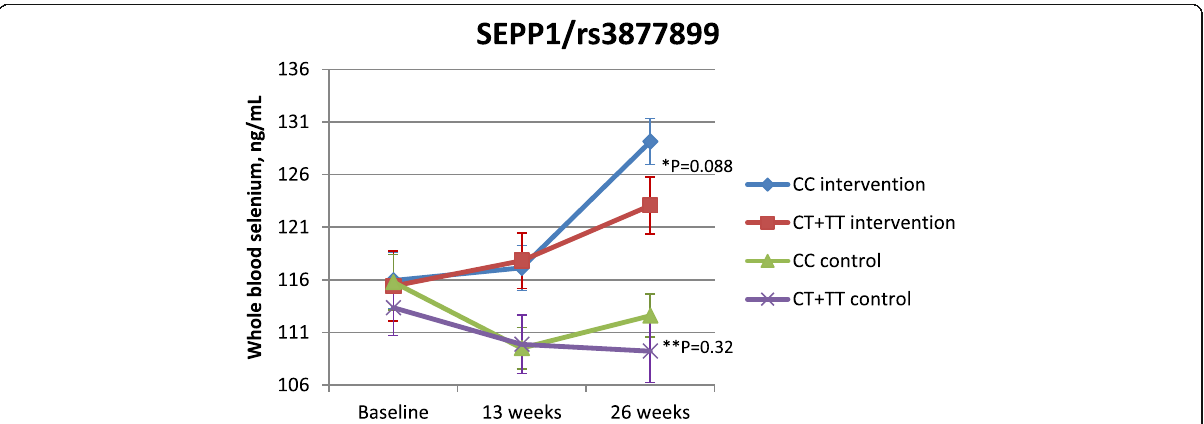
Fig. 1 Association between mean concentrations of whole blood selenium and the SELENOP /rs3877899 polymorphism. Mean concentrations of whole blood selenium ± SD for the intervention and control group estimated by linear multiple regression adjusted for baseline level of whole blood selenium. P values for difference in mean whole blood selenium concentrations at week 26 for genotype effect within the intervention group (*) and within the control group (**), respectively, are